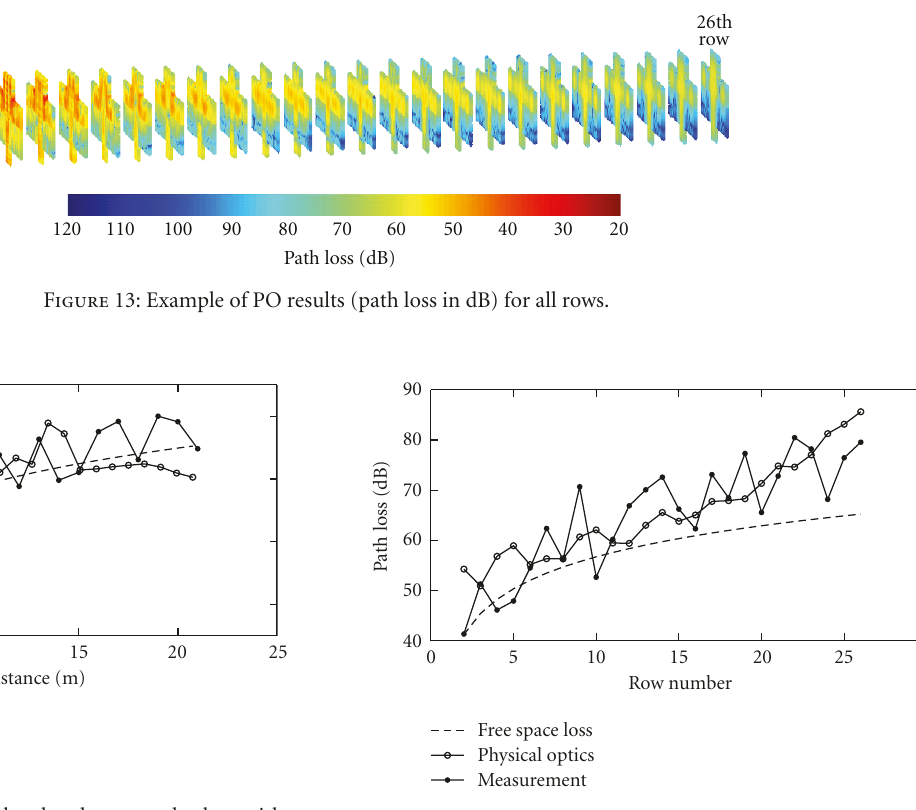
Figure 16: Comparison of simulated and measured values, B seat.